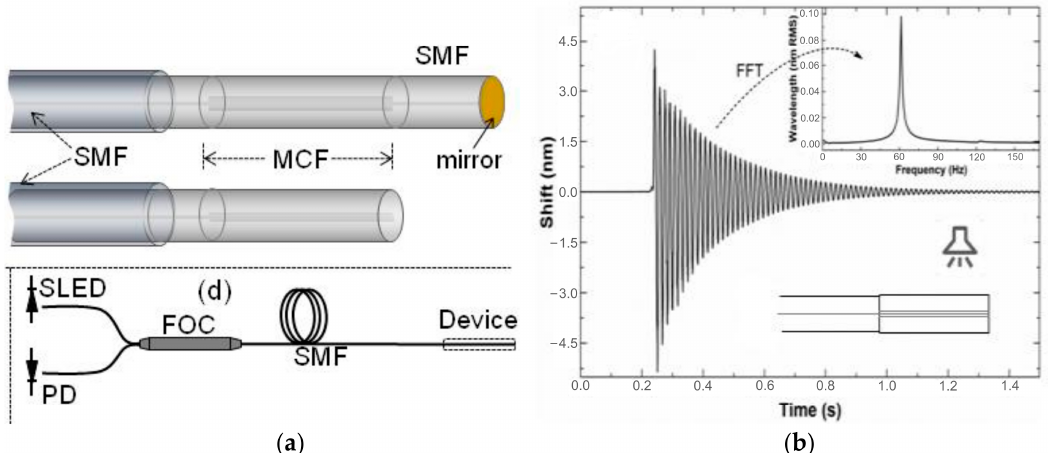
Figure 22. ( a ) Illustration of the vibration sensor heads, including the SMF–MCF–SMF structure and the SMF–MCF structure, and the schematic of the experimental setup. ( b ) The wavelength shift vs. time of the SMI when it was vibrating freely, and the inset shows the FFT of the time domain signal [115].